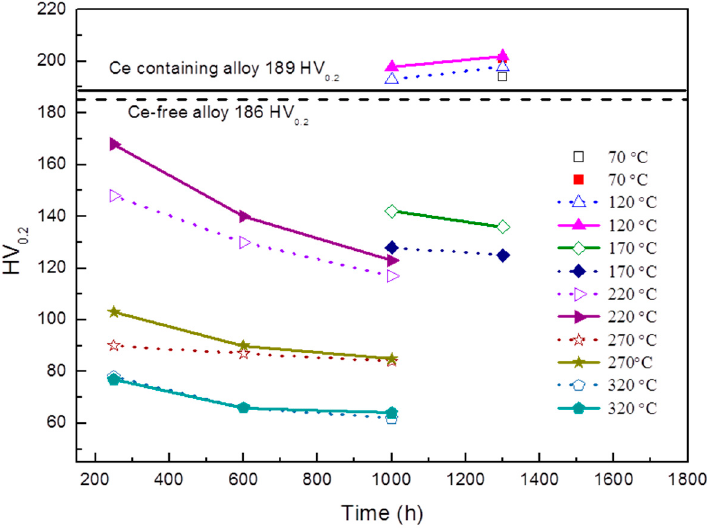
Figure 2. Thermal stability curves of Ce-containing and Ce-free alloys during thermal exposure at the temperature range 70–320 °C for soaking time from 250 h to 1300 h.